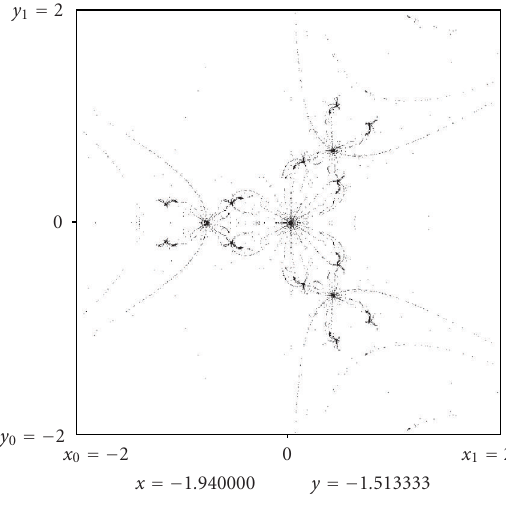
Figure 6.2. Second generation of Julia set.